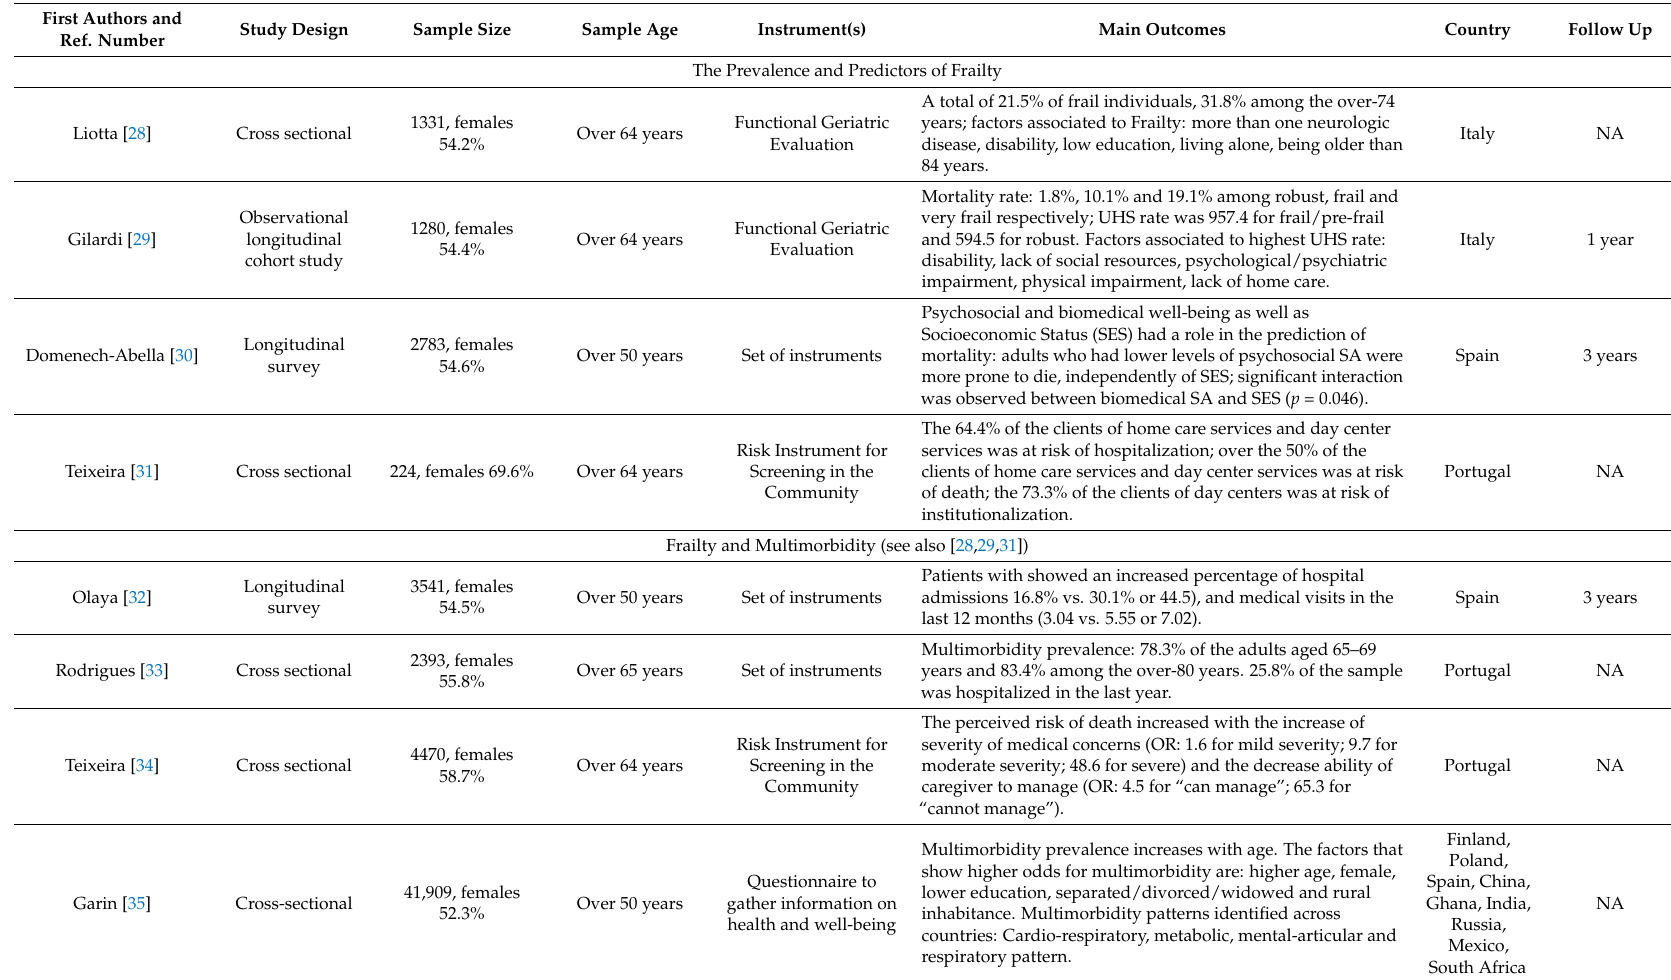
Table 2. Frailty and associated